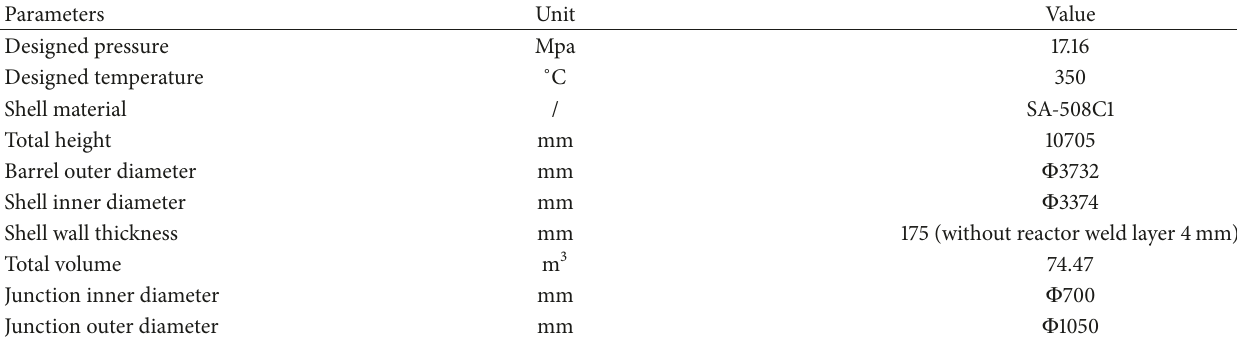
Table 3: The main parameters of RPV.